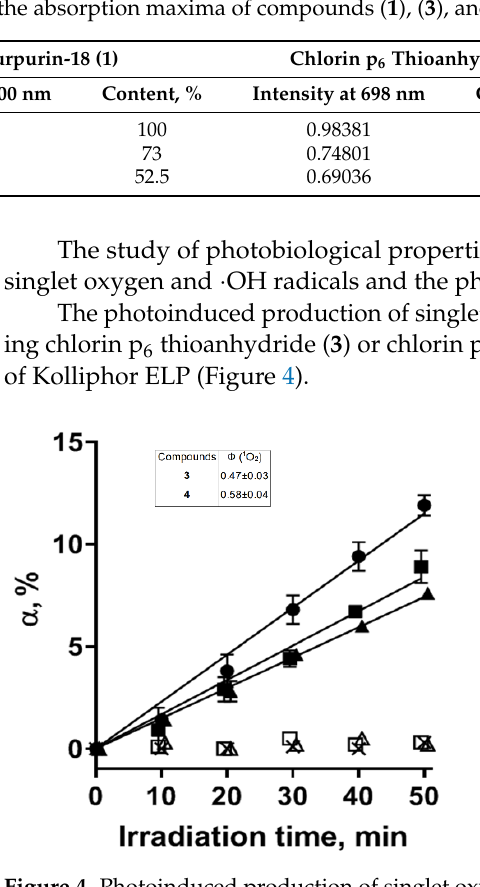
thioanhydride ( 3 ) and 53 ± 8 µ mol L − 1 for chlorin p 6 thioanhydride ( 4 ) after incubation with chlorin p 6 thioanhydride ( 3 ) or chlorin p 6 selenoanhydride ( 4 ) at 1 µ mol L − 1 for 2